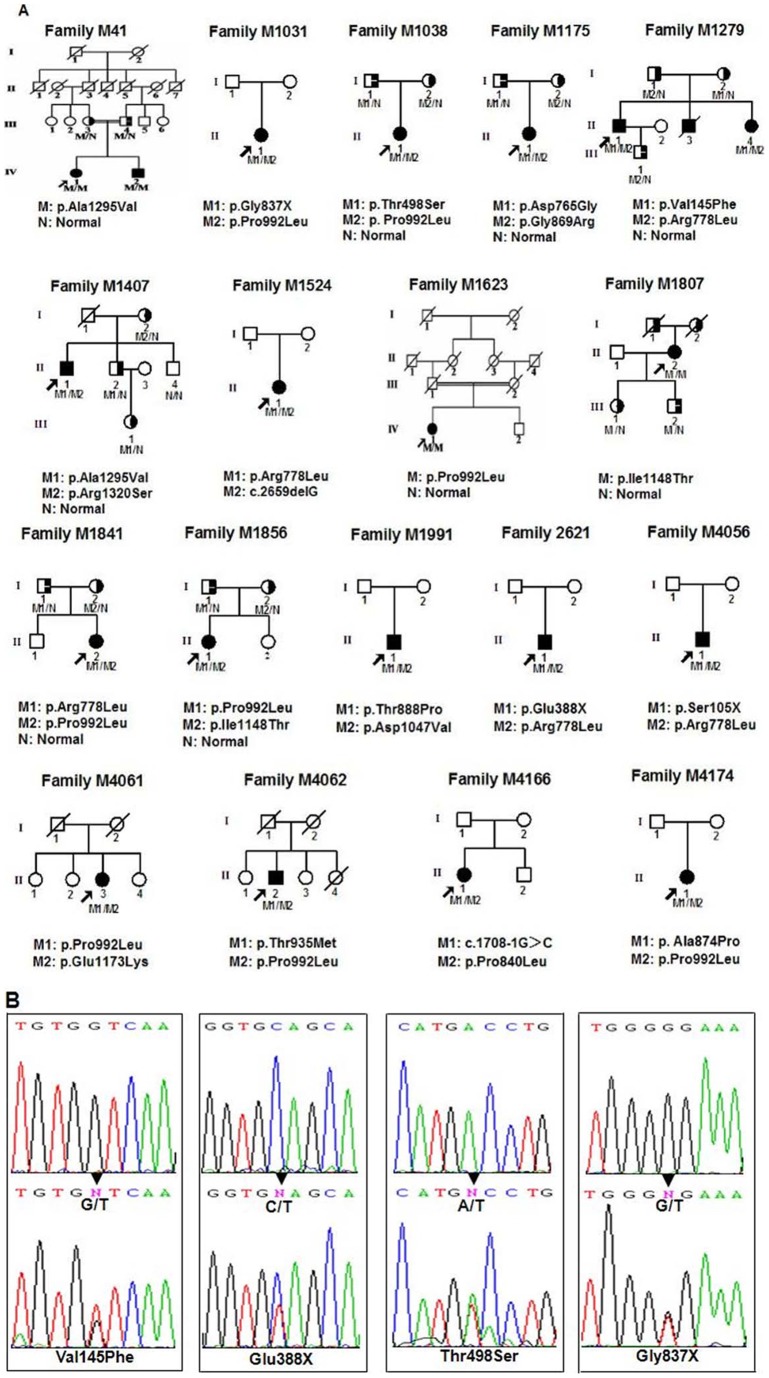
Pedigree figures of WD families (A) and (B) the sequences of the four novel mutations.Arrowheads indicate nucleotide changes.